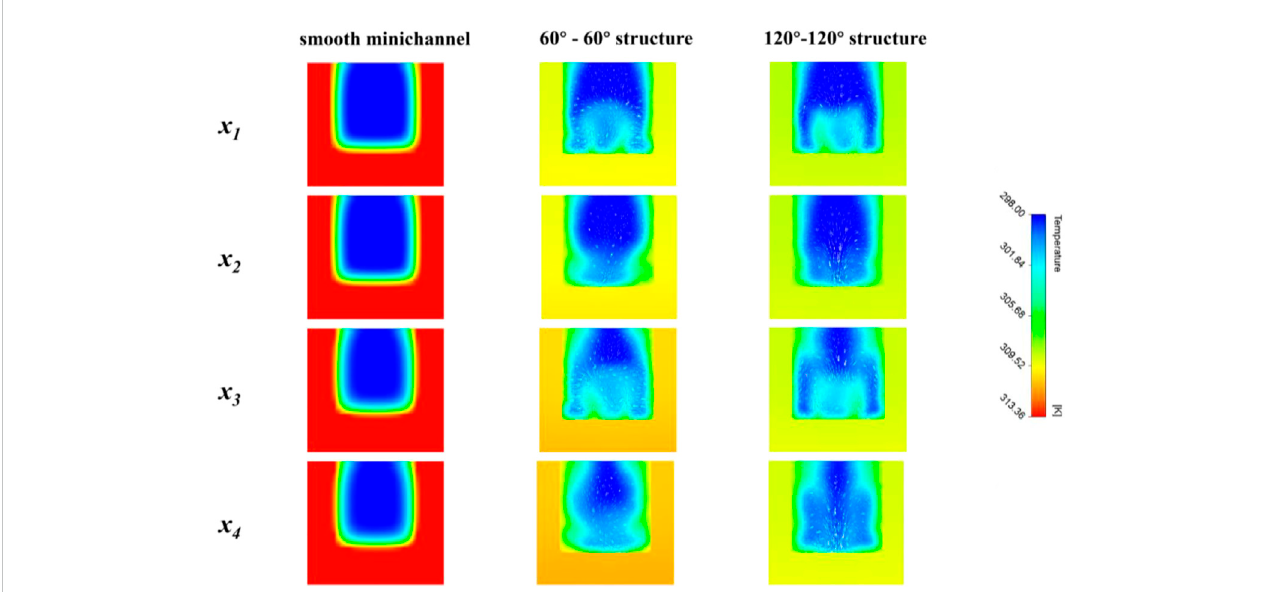
FIGURE 9 Contours of temperature on different spanwise cross-sections for different minichannel con fi gurations: x 1 = 19mm; x 2 = 20.5mm; x 3 = 37mm; x 4 = 38.5 mm.